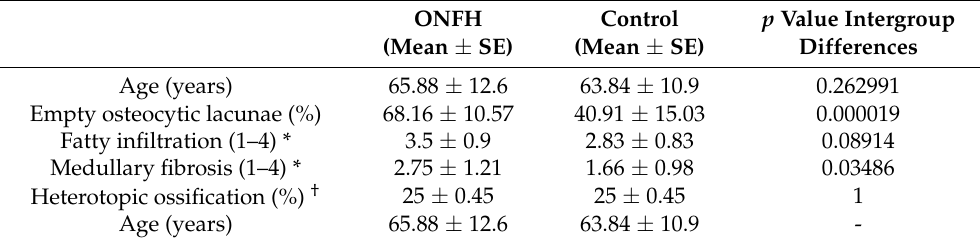
Table 2. Histological analysis data from femoral head specimens.